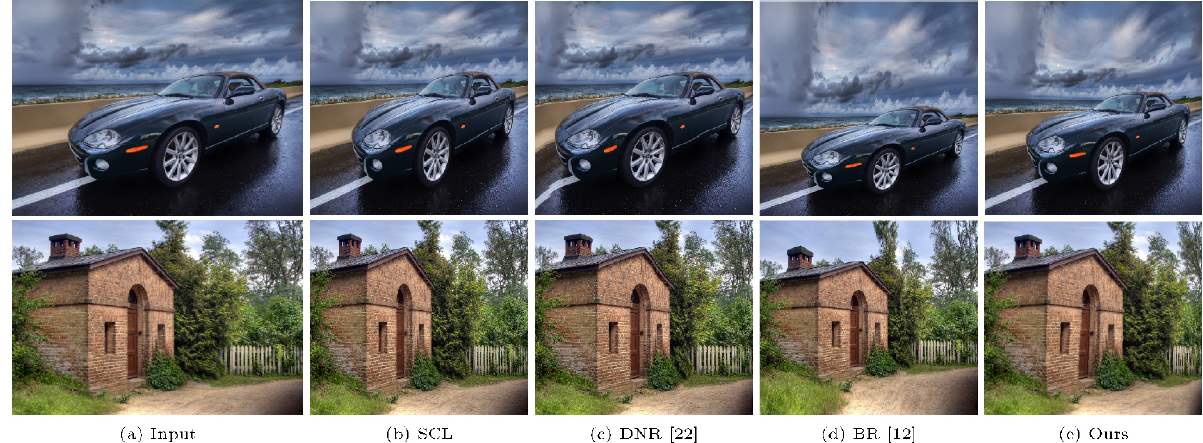
Fig. 9 Results of the proposed warping method and manual interactive methods when resizing images to 75% of their original width. (a) Input. (b) Linear scaling result. (c) Result using DNR. (d) Result using BR [12]. (e) Our result using 50 elements (approx. 460 DOFs).